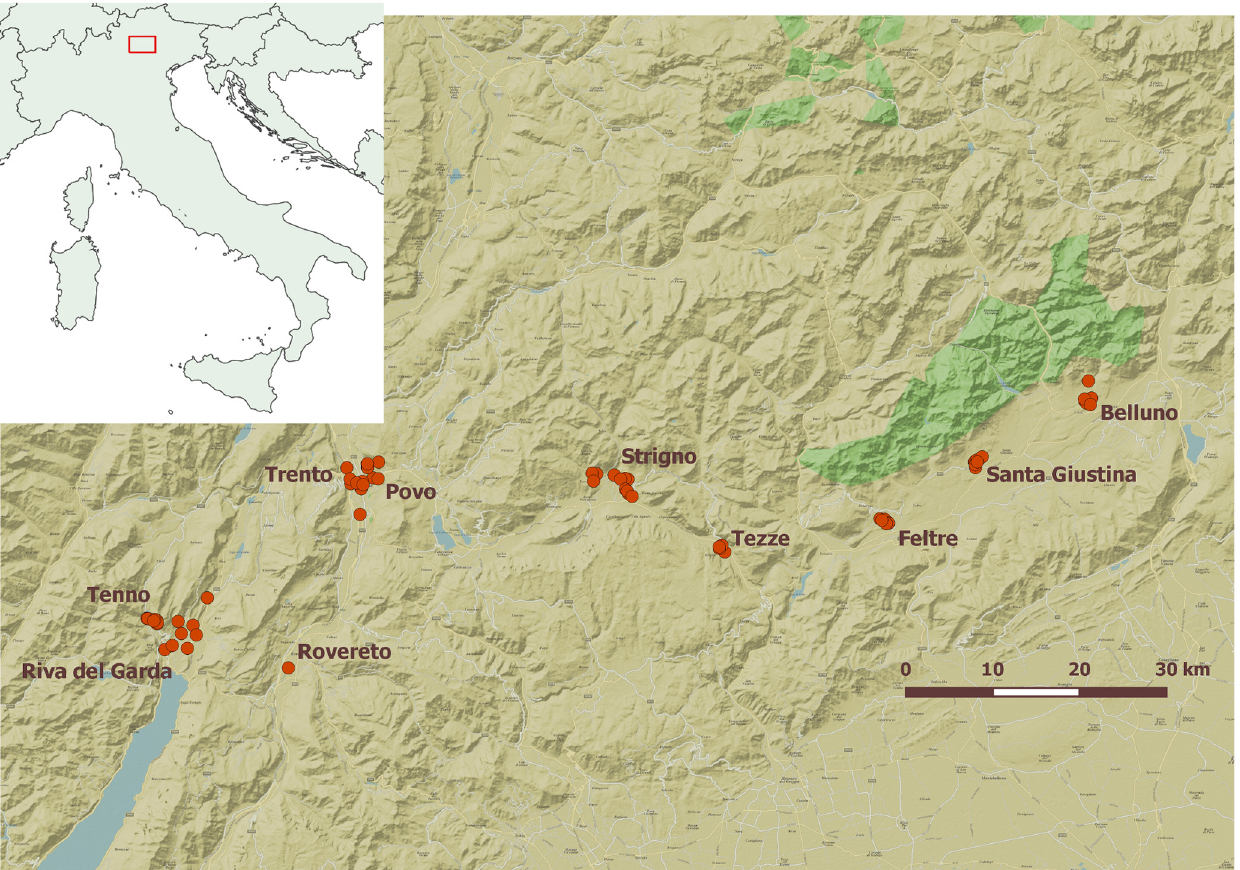
Fig 1. Geographic distribution of trap locations (red circles) and municipalities in the study area.